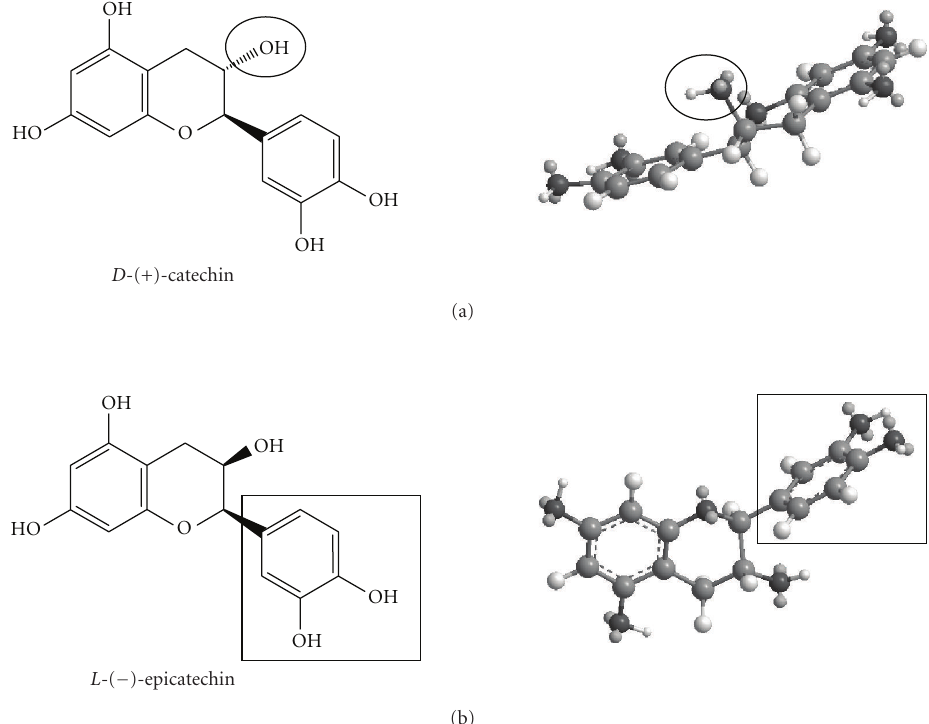
Figure 3: Three-dimensional structure of (a) D -(+)-catechin and (b) L -(–)-epicatechin with MM2